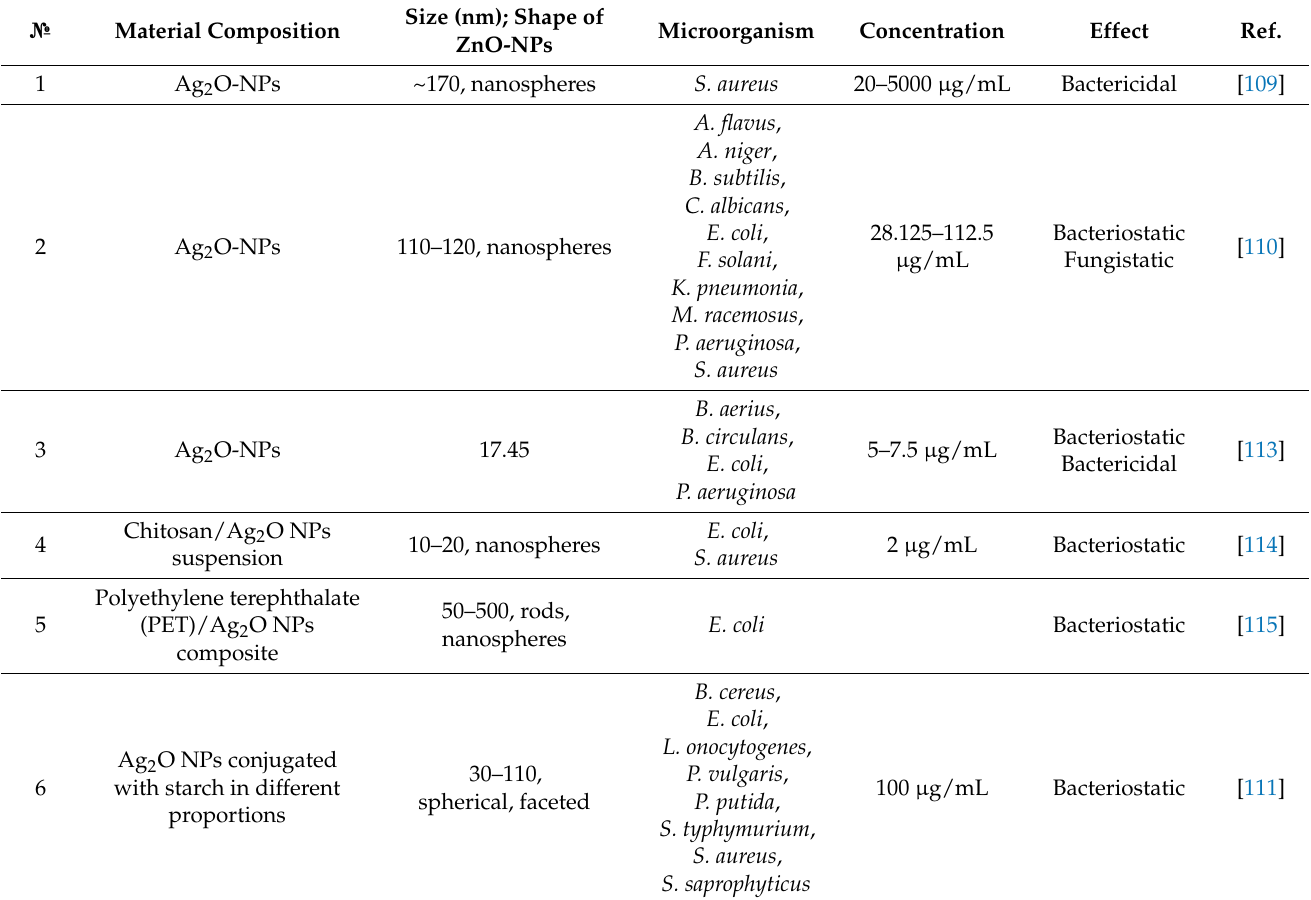
Table 2. Literature data on the antibacterial activity of Ag 2 O NPs and nanocomposites based on